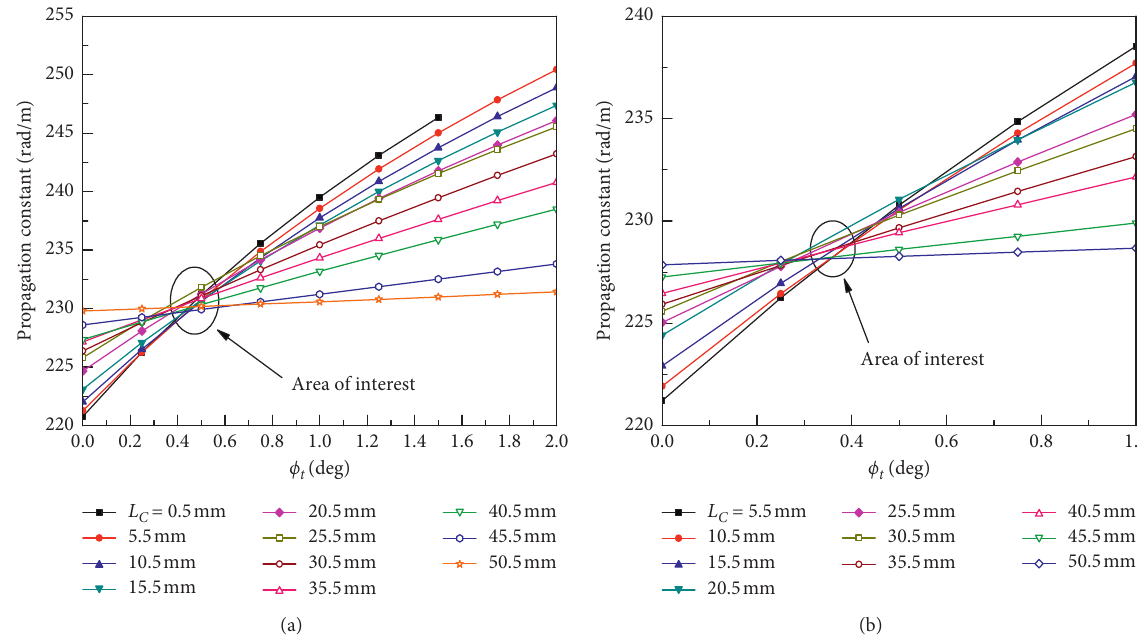
Figure 3: Wave propagation characteristics of conformal SIW along distance, L (b) nose-cone.